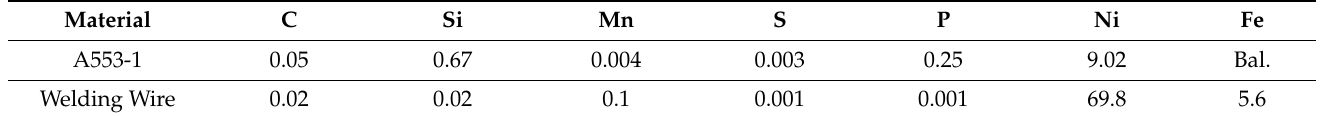
Figure 2. Schematic diagram for the flux cored arc welding process [7]. Table 2. Chemical composition of base metal Table 1. Mechanical properties of base metal [7].